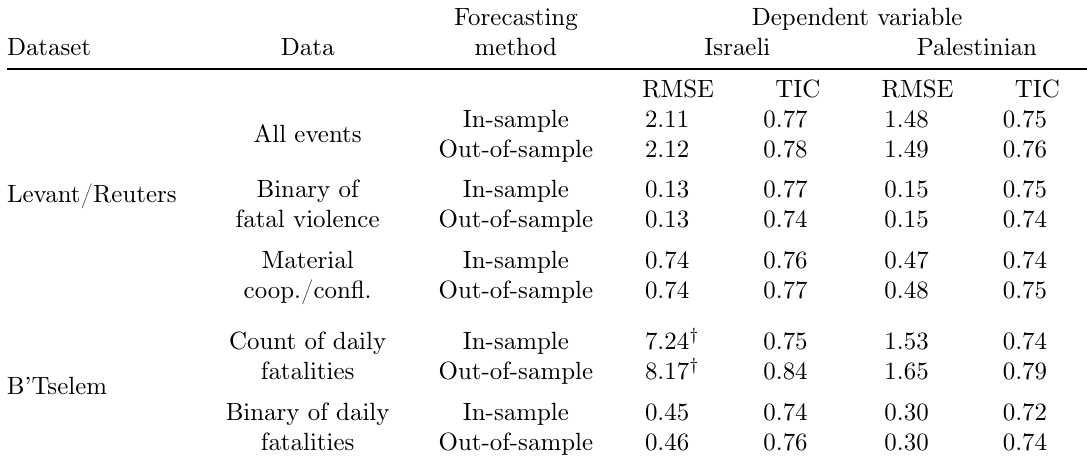
Table 3: Robustness Checks Forecasting Dependent variable Dataset Data method